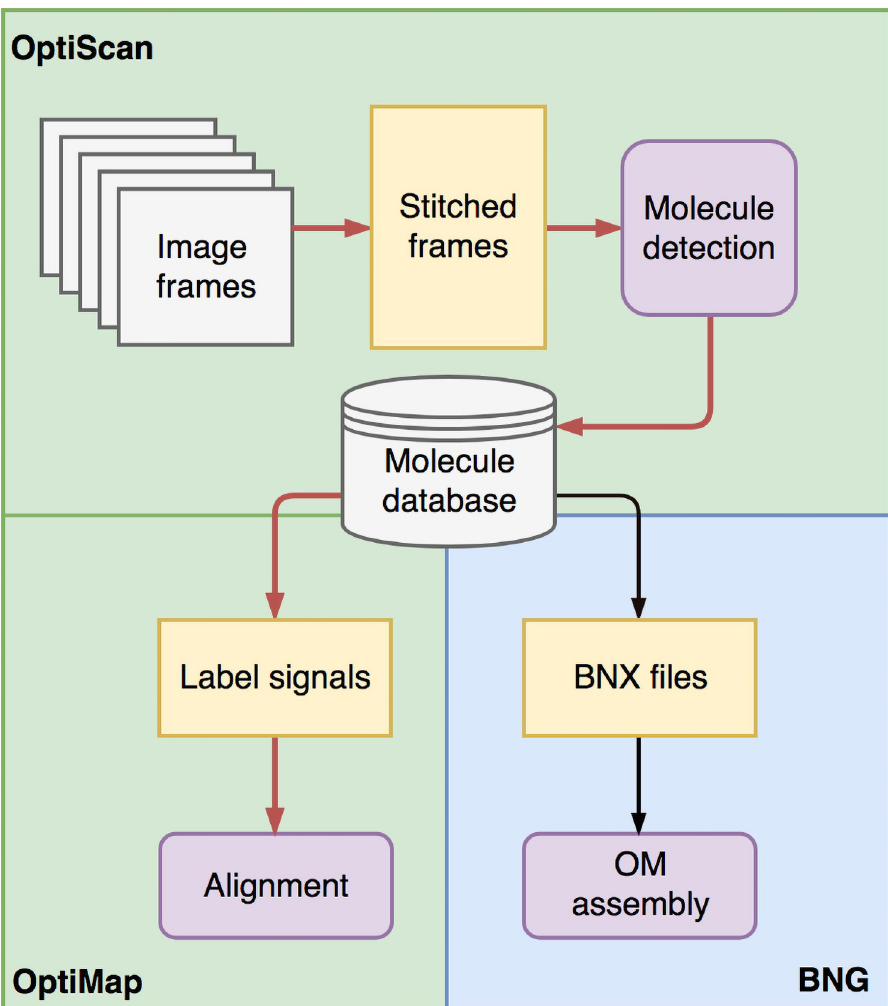
Fig 2. OptiTools workflow. OptiScan detects molecules and stores these in a database, which can then be used by OptiMap for molecule-to-molecule or molecule-to-reference alignment, or exported for use with BNG methods in a BNX molecule